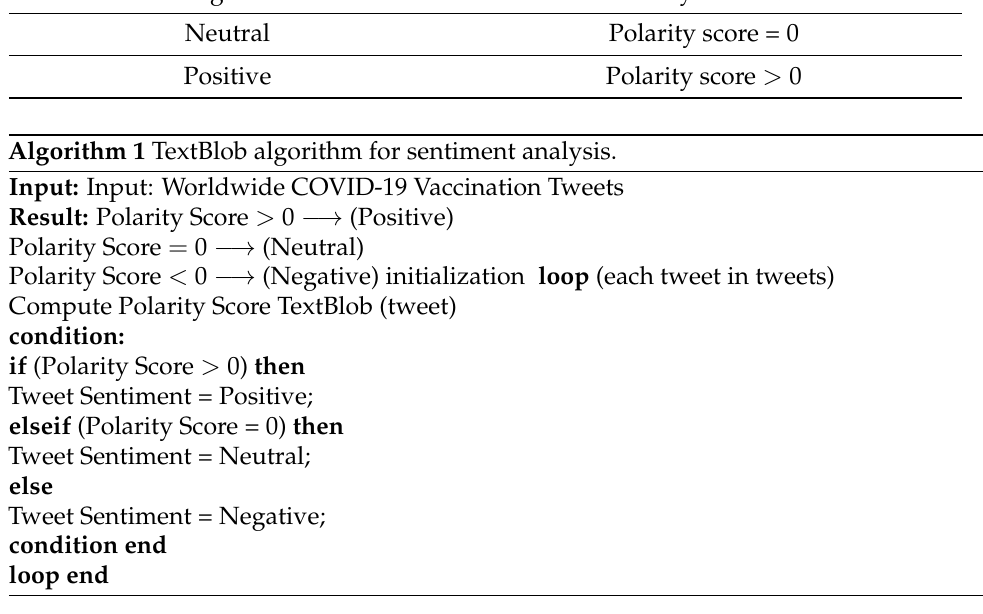
Table 6. TextBlob sentiment score range.